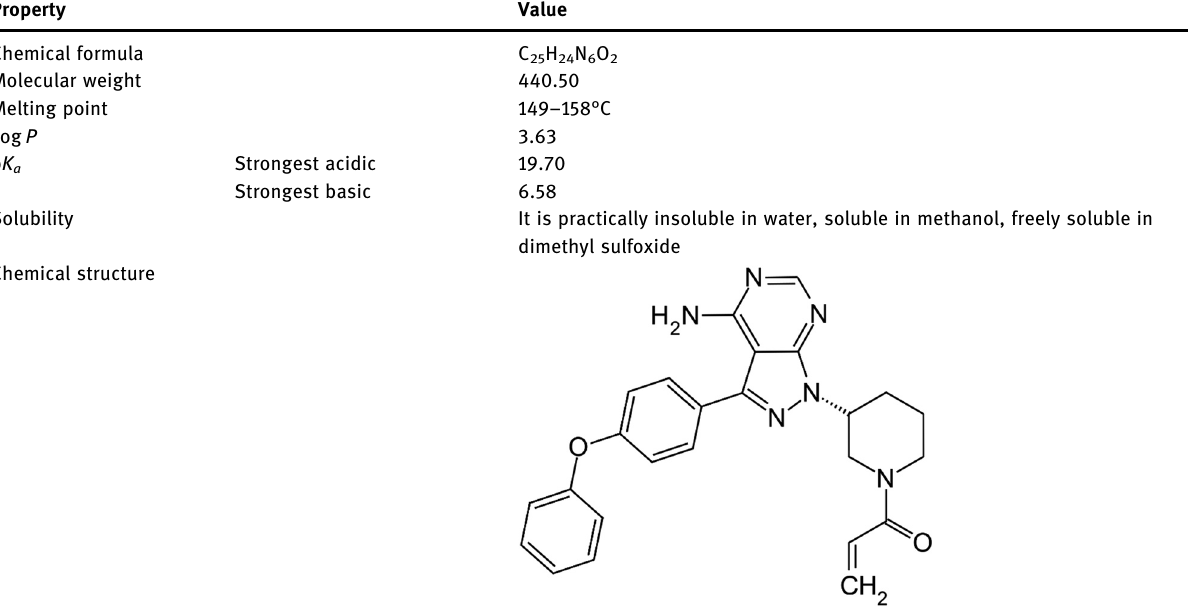
Table 1: Chemical properties of ibrutinib